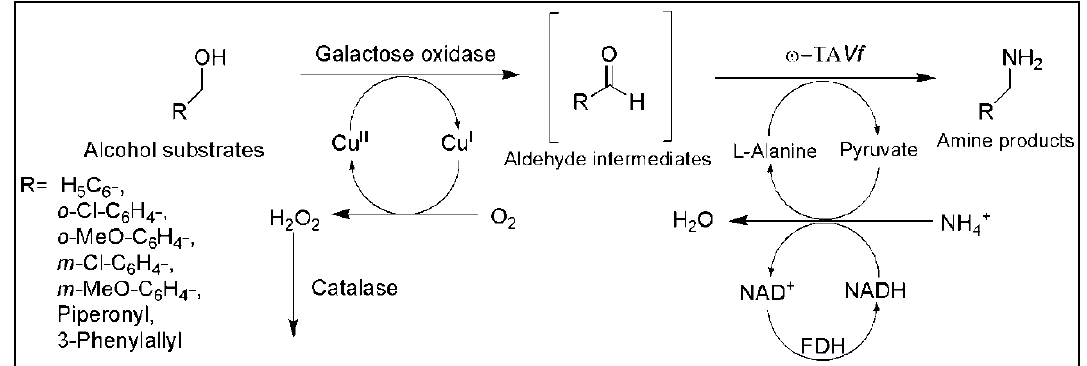
Figure 6. Biocatalytic cascade employing galactose oxidase and ω -TA for the amination of benzylic/cinnamic alcohols (reprinted from [114], with permission of The Royal Society of Chemistry). (Reaction conditions: 50 mM substrate, 20 mg lyophilized E. coli BL21(DE3) cells over-expressing galactose oxidase, 0.075 mg/mL 2,2 ′ -azino-bis(3-ethylbenzothiazoline-6-sulfonic acid), 20 mg, lyophilized E. coli BL21(DE3) cells over-expressing ω -TA Vf , Sodium phosphate buffer (100 mM, pH 7.0), 1 mM PLP, 10 mM CuSO 4 , 7.5 mg alanine dehydrogenase, 20 U glucose dehydrogenase, 150 mM L -alanine, 120 mM (2.4 equiv) glucose, R.T., 24